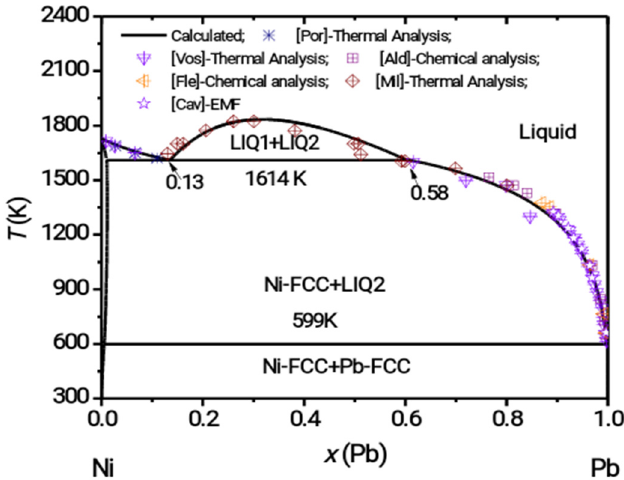
Figure 4. Calculated phase diagram of Ni-Pb system and experimental data from literature ([Vos]